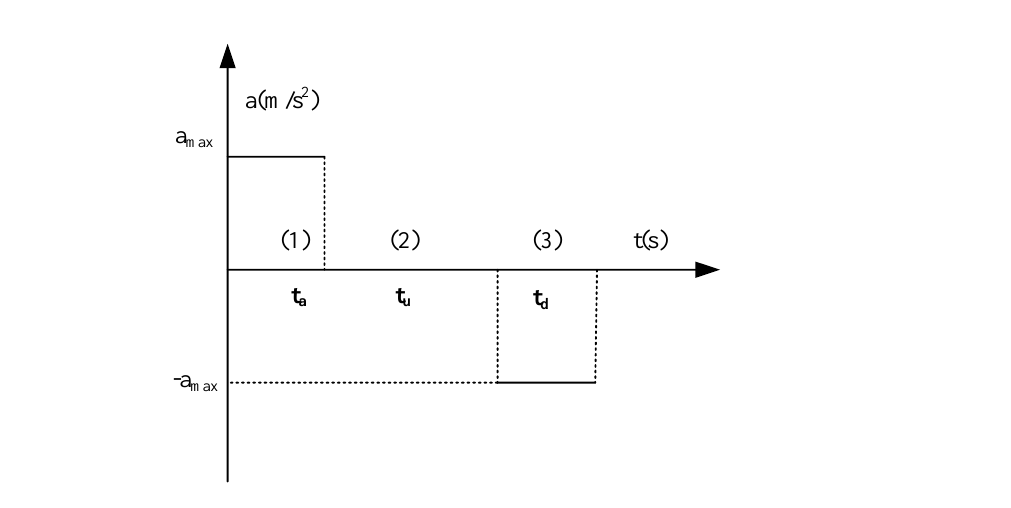
Figure 9. Acceleration curve of trolley during continuous acceleration / deceleration movement.